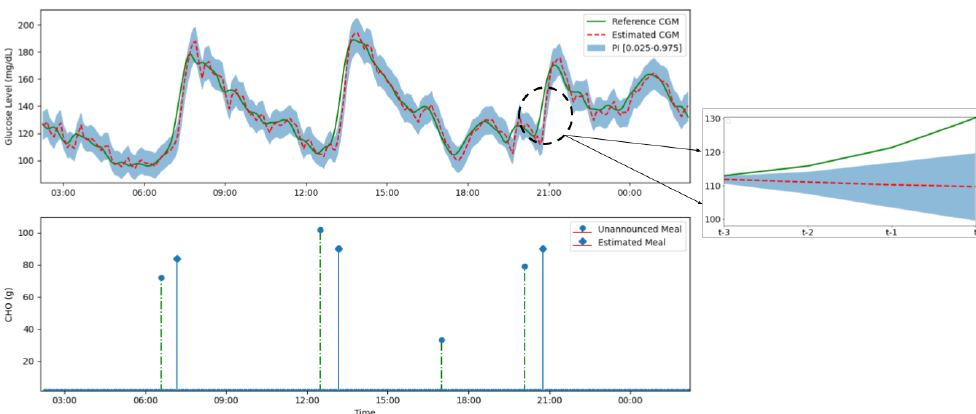
Figure 2. ( Top ) A figure showing the multitask seq2seqmodel predicting the 20 min glucose trajectory for a 95% prediction interval (lightly shaded blue area) over a 24-h period. The estimated glucose level (red dashed line) closely follows the reference glucose level from the CGM (green line) except during unannounced meals. In the instance of an unannounced meal—such as dinner just before 9 p.m.—a significant and persistent deviation in glucose trajectory from estimated trajectory occurs (shown on the right) which leads to a meal detection and estimation. ( Bottom ) The unannounced meal and reconstructed estimated meal. Certain meals such as the small snack between 3 p.m. and 6 p.m. are not detected as reliably since they only result in a non-significant deviation in the glucose